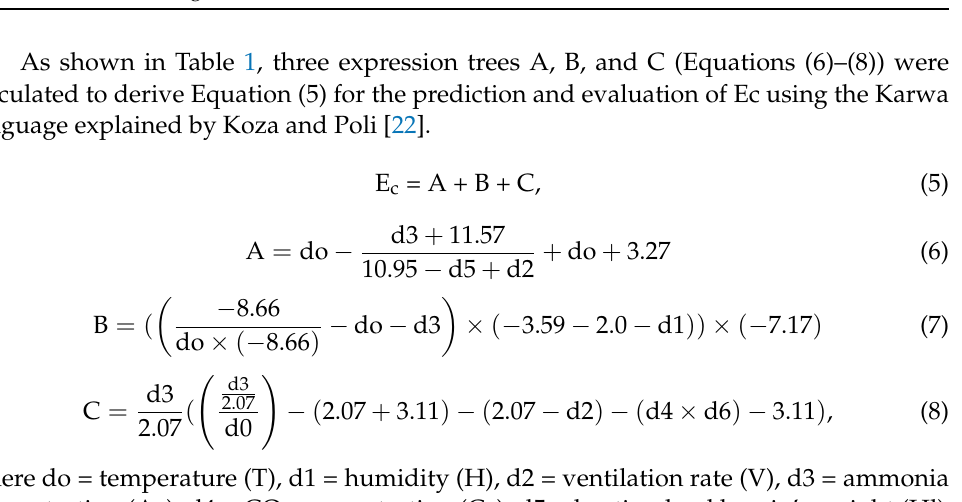
Table 1. General settings for prediction model. Items Genes (expression trees) 3 Chromosomes 200 Head size Set of